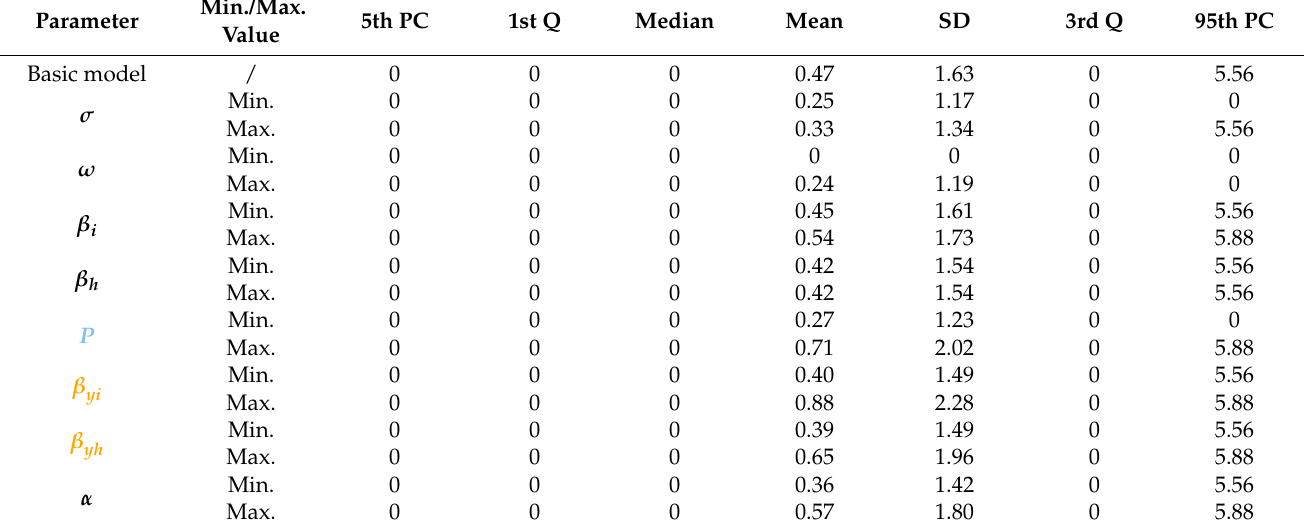
Table 6. Proportion of clinically infected cows from the sensitivity analysis of the epidemiologically most significant parameters. The parameters and their values in the basic model and the sensitivity analysis are defined in Table 3. Percentile, PC; quantile, Q; standard deviation,